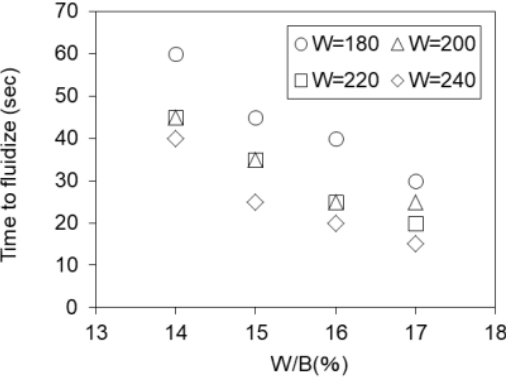
Figure 9. W/B and fluidisation time.